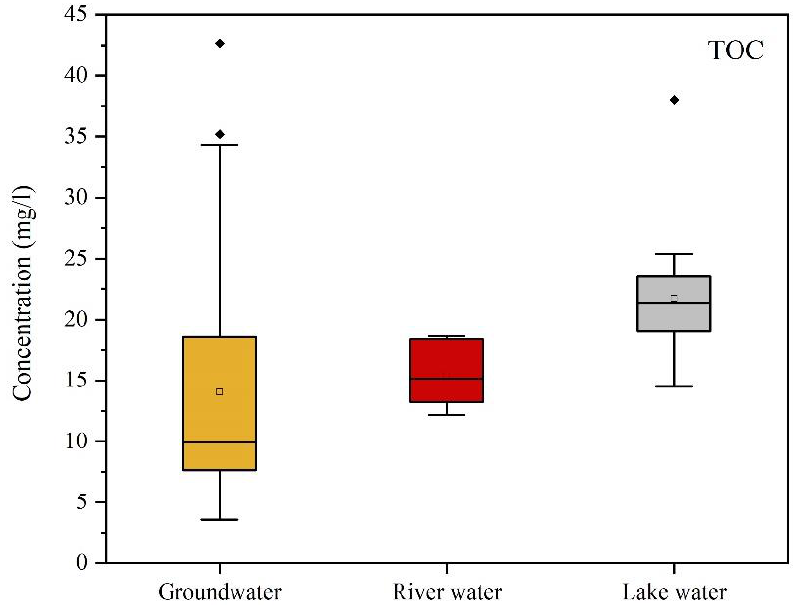
Figure 7. The TOC concentrations in different waters.